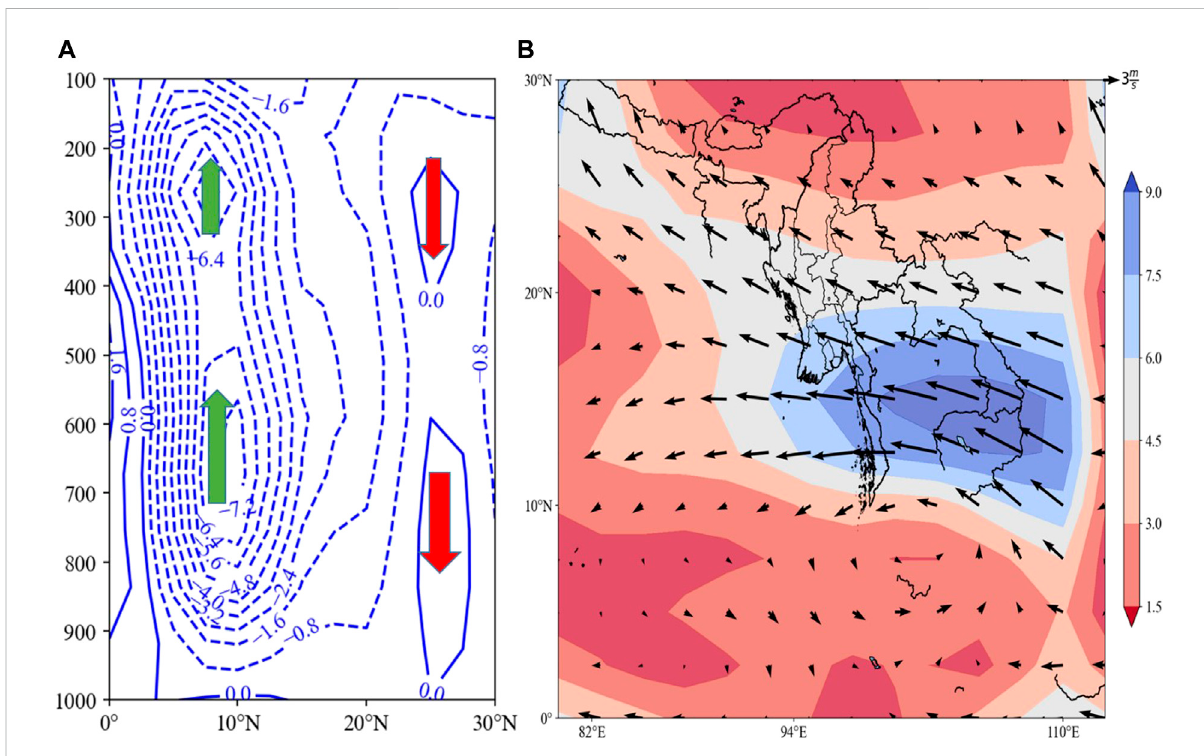
FIGURE 12 Meanof (A) pressureverticalvelocityand (B) windscirculationfortheperiodfrom1970to2014.Arrowsingreenandpointingupindicatesrising motion and arrows in red pointing down indicates descending motion while the shaded represents the wind